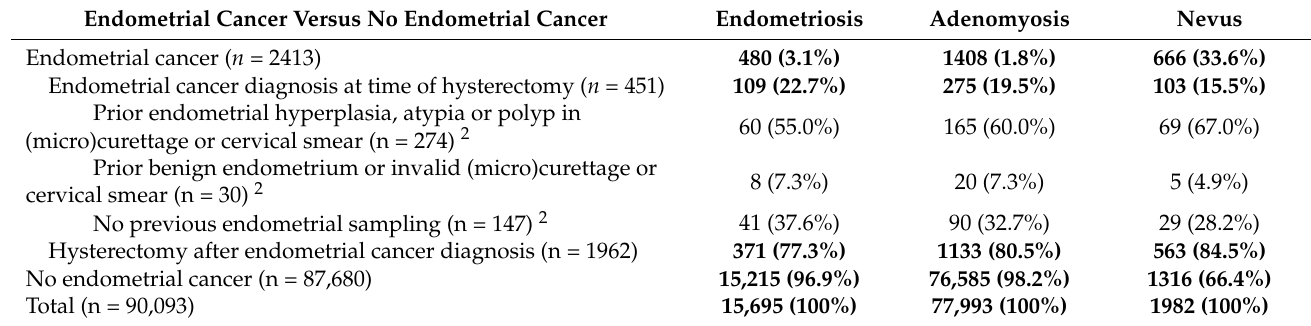
Table 2. Observed number of hysterectomies of women with endometriosis, adenomyosis or a benign dermal nevus with respect to endometrial cancer or no endometrial cancer. Further specification of all women with endometrial cancer diagnosis at time of hysterectomy with information on previous endometrial tissue sampling 1 . Endometrial Cancer Versus No Endometrial Cancer